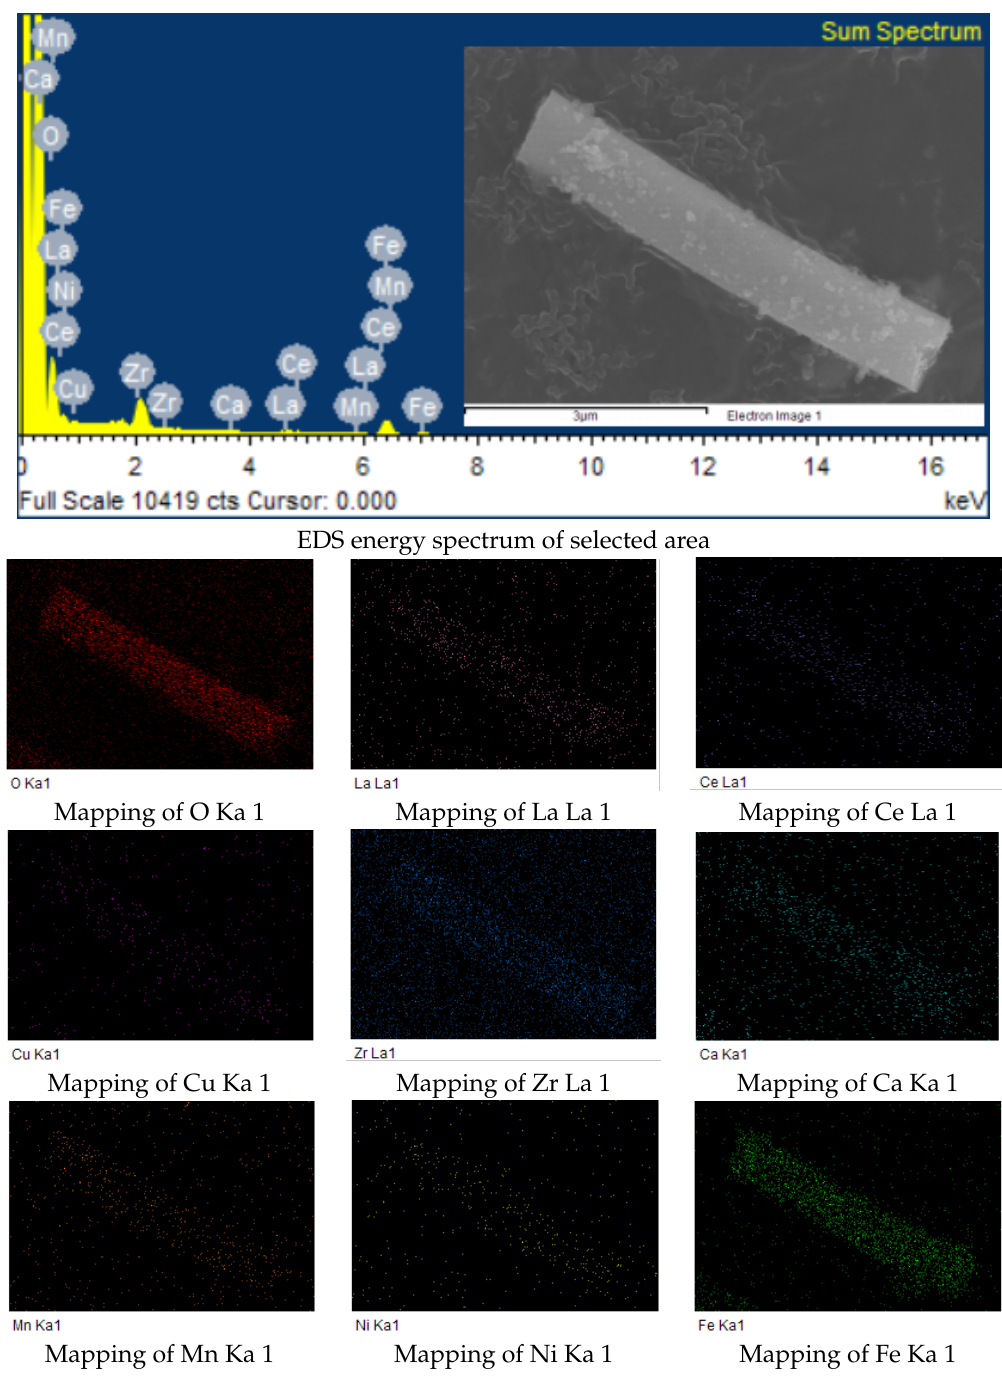
Figure 4. SEM and mapping of high entropy spinel ferrite nanofibers. The crystallographic surface index, half-height width, and grain size of the high- entropy spinel ferrite nanofibers were analyzed using Jade software. The main peak at 2 θ was 35.6 ◦ , corresponding to the (311) plane, FWHM of 0.818 ◦ , and grain size of ∼ 10.3 nm. Additional characteristic peak parameters are listed in Table